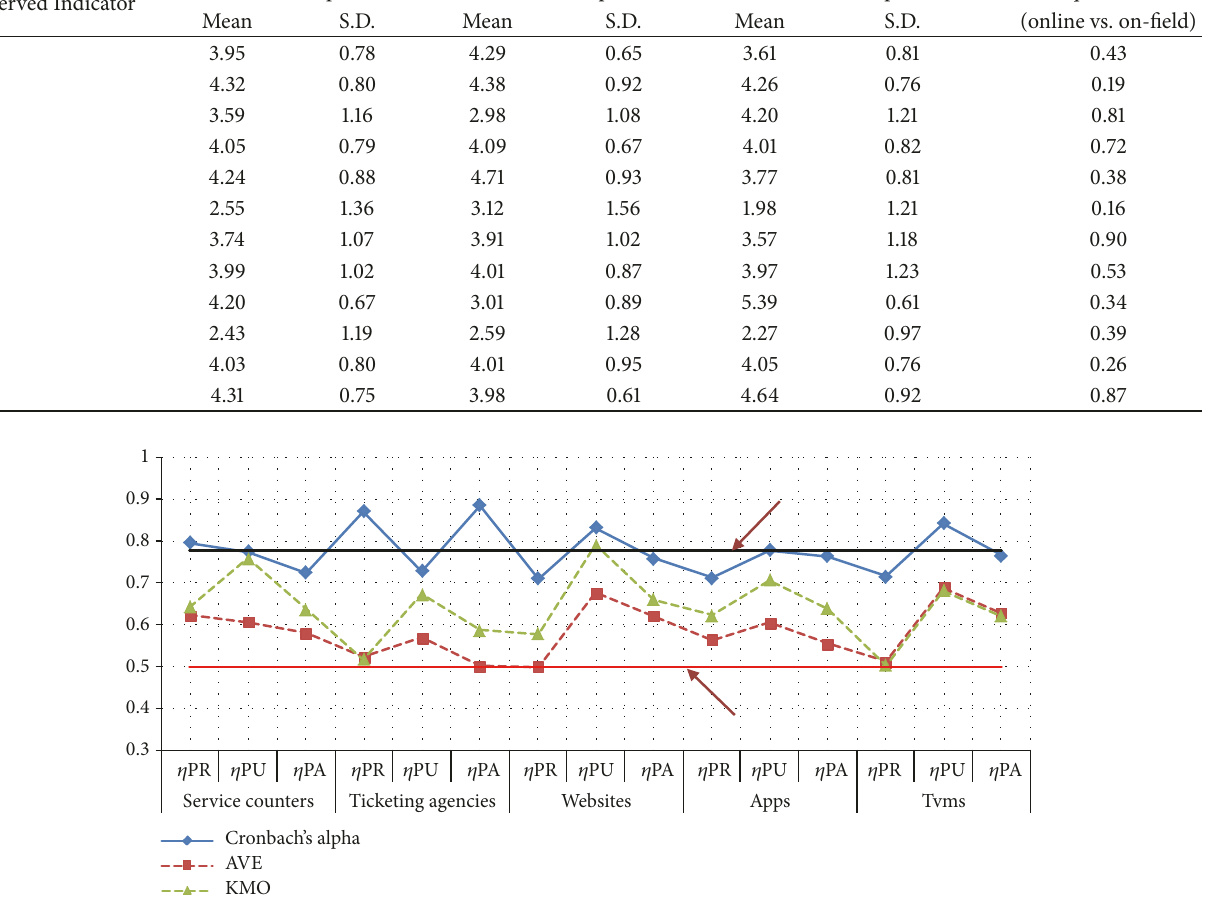
Figure 2: Reliability and validity tests of the sample.